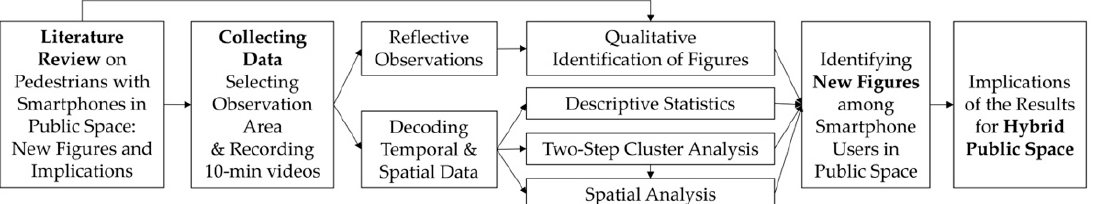
Figure 4. Research methodology.